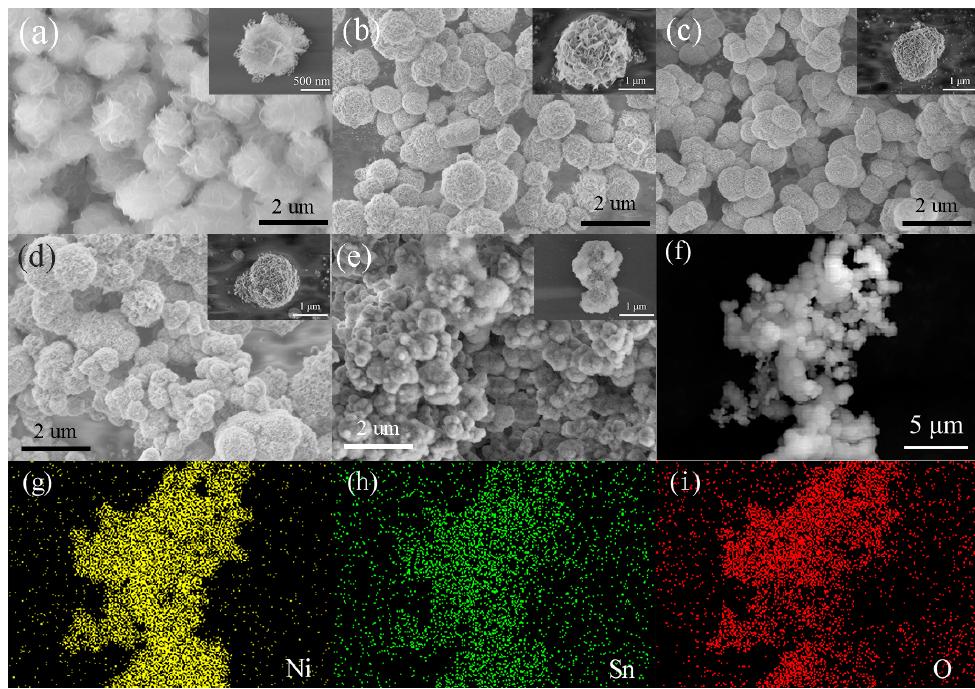
Figure 3. ( a – e ) Panoramic SEM images of the NiO, SNM-2, SNM-4, SNM-8, and SNM-12 samples, respectively; ( f – i ) SEM image and the elemental mapping of the Ni, Sn and O in the SNM-8 sample.